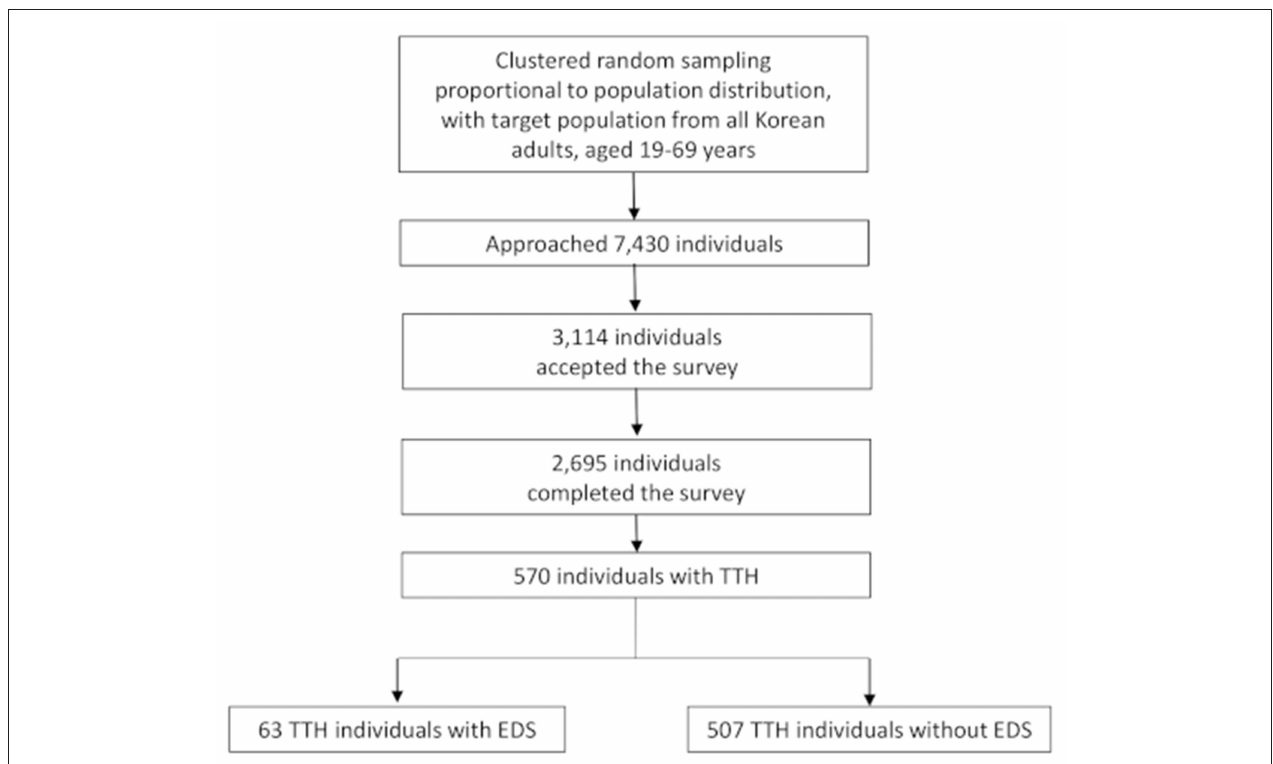
FIGURE 1 | Flow chart depicting the participation of subjects in the Korean Headache-Sleep Study.